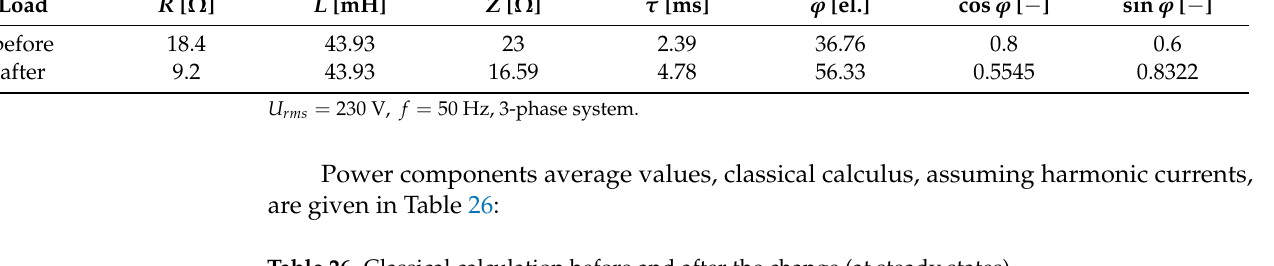
Table 26. Classical calculation before and after the change (at steady states).